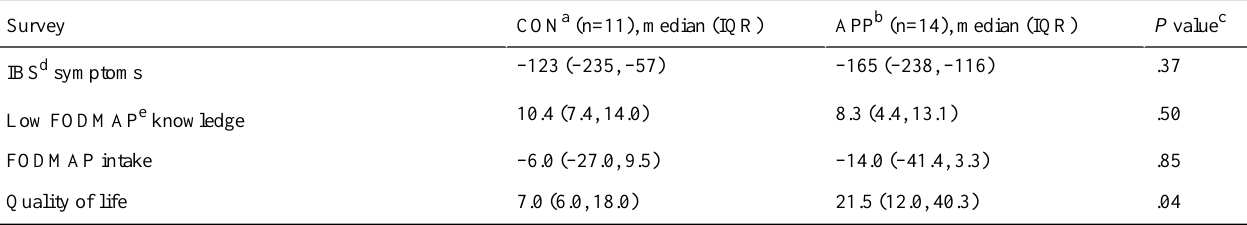
Table 2. Thirty-day change in survey